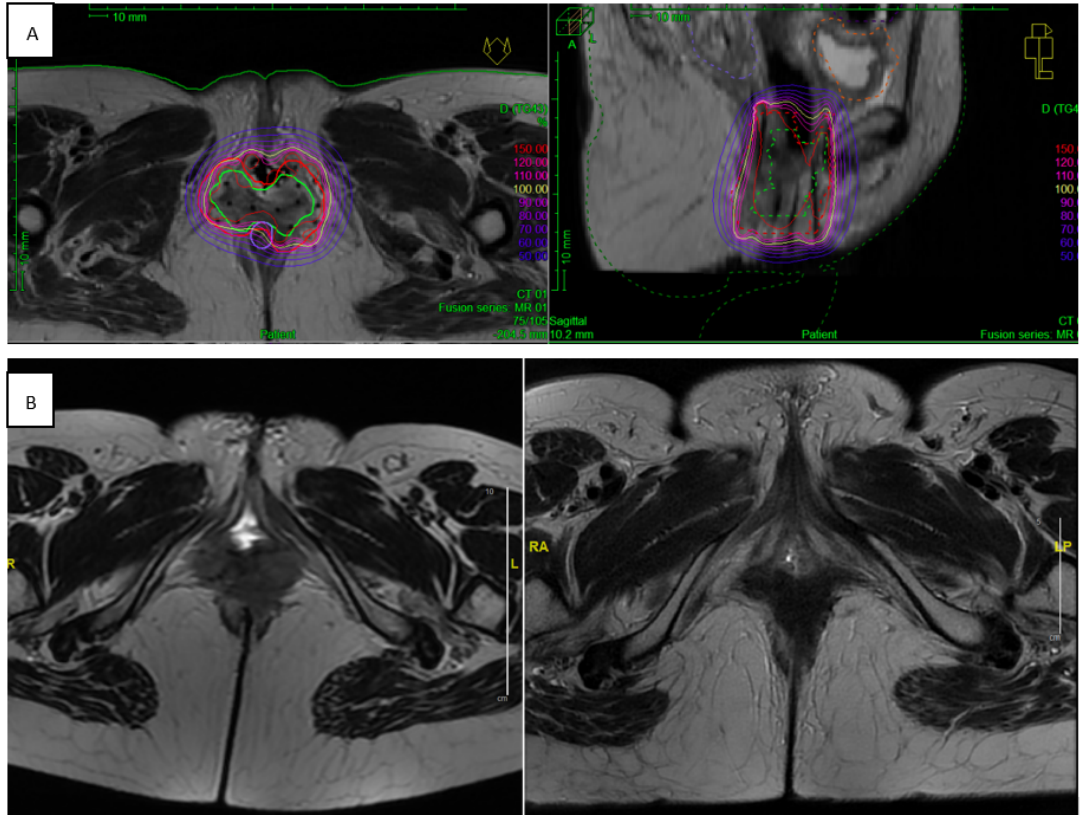
Figure 2. Example of MRI-guided PDR BT reirradiation for vulvo vaginal recurrence. ( A ) MRI-guided PDR BT reirradiation implant to a 6 cm vulvo-vaginal recurrence of cervical epidermoid carcinoma, initially treated in another center with pelvic EBRT (45 Gy in 25 fractions) followed by HDR BT (25 Gy in 5 fractions of 5 Gy). Because of the size (>3 cm) of the vaginal recurrence, the patient was treated first by pelvic EBRT (39.6 Gy in 22 fractions of 1.8 Gy in the tumor, and 45 Gy in 25 fractions of 1.8 Gy in inguinal lymph nodes), followed by an MRI-guided PDR BT with vaginal mold associated with free-hand needles, at the dose of 20.10 Gy in 67 pulses of 0.30 Gy. The EQD2 reirradiation doses (EBRT + BT) were the following: HR-CTV D 90 = 67.42 Gy, bladder D2cc = 42.73 Gy, rectum D2cc = 60.57 Gy, sigmoid D2cc = 39.47 Gy, and small bowel D2cc = 39.11 Gy. ( B ) Pelvic MRI showing the vulvo-vaginal recurrence before re-RT (left), and a complete response 8 weeks after MRI-guided PDT BT (right).